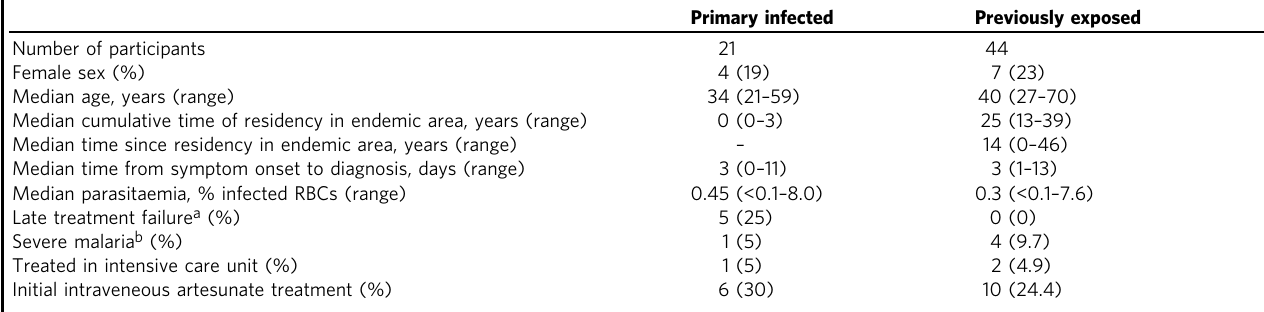
Table 1 Descriptive statistics of the study participants.